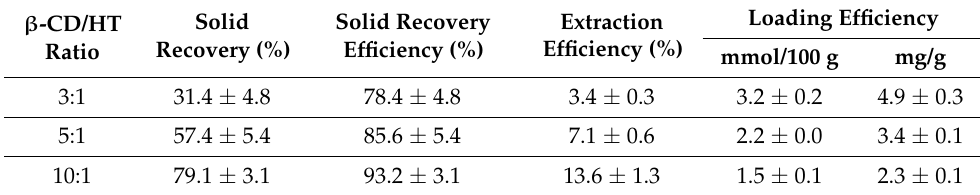
Table 2. Solid recovery, extraction, and loading efficiencies for a 10 mM HT solution.